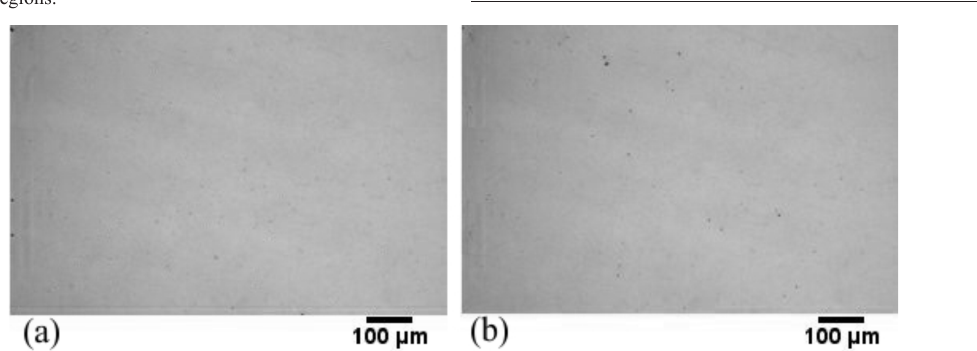
Figure 5. Regions on the surface of superaustenitic stainless steel before (a) and after (b) corrosion tests without attack. The black dots represent typical refractory oxides